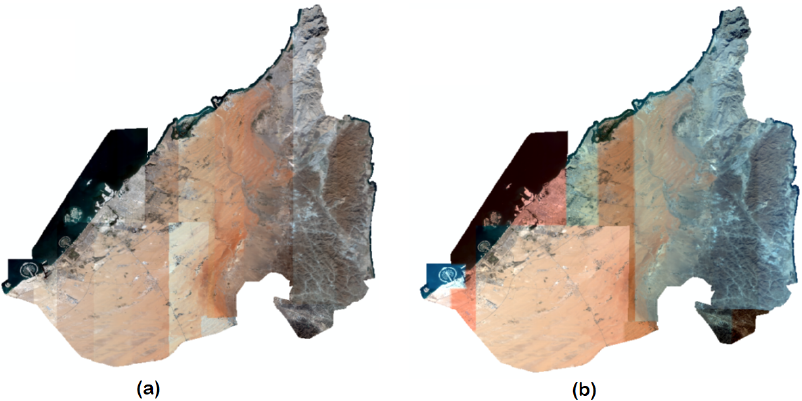
Figure 2. WorldView-2 tiles: ( a ) for Northern Emirates region, UAE and ( b ) a preview of color balancing issues observed using mosaicking algorithm available in Envi software.